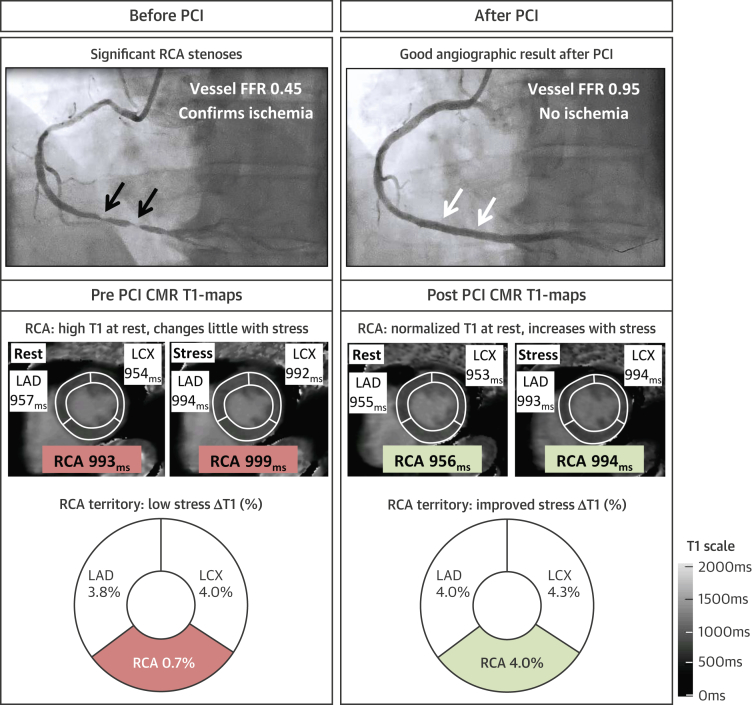
Noninvasive Assessment of Myocardial Ischemia Using Gadolinium-Free CMR Stress T1 MappingA 69-year-old male patient presented with angina for 3 months. On angiography, he had 2 significant right coronary artery (RCA) stenoses (black arrows), with a combined vessel fractional flow reserve (FFR) of 0.45, indicating coronary ischemia. The 1.5-T cardiac magnetic resonance (CMR) before coronary angiography showed an elevated resting T1 and reduced stress T1 response in the RCA territory (T1rest 993 ms to T1stress 999 ms: ΔT1 = 0.7%). Percutaneous coronary intervention (PCI) relieved the stenoses with good angiographic result (white arrows) and normalization of vessel FFR to 0.95. This finding was accompanied by significant improvements in the rest and stress T1 responses (T1rest 956 ms to T1stress 994 ms: ΔT1 = 4.0%).